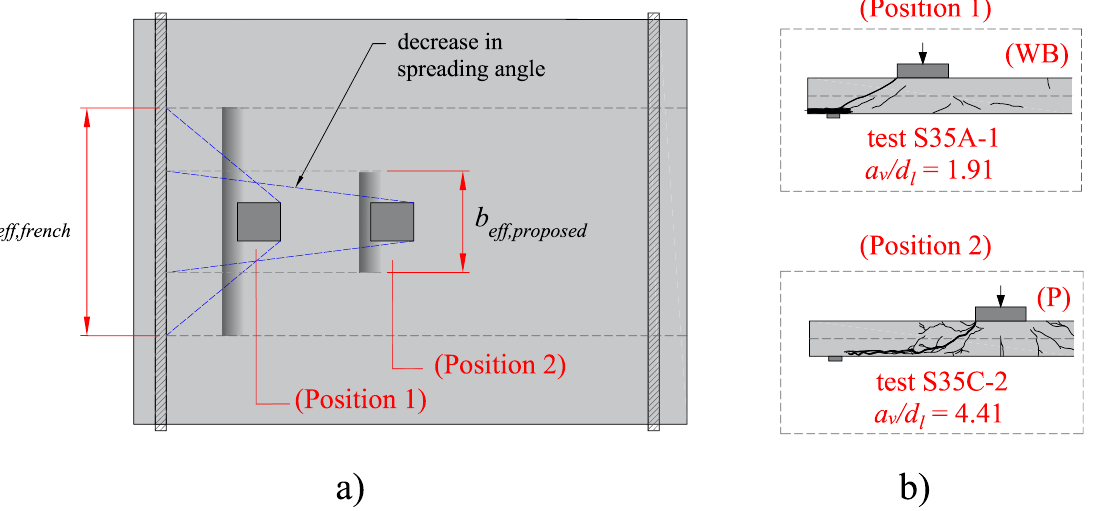
Figure 12. ( a ) Effective shear width corrected as a function of the shear slenderness a v / d l (the pro- posed effective shear width decreases as the shear slenderness increases) and ( b ) failure mechanism varying from one-way shear as wide-beam (WB) to punching shear (P) increasing a v / d l for the tests from Reiβen et al. [6].